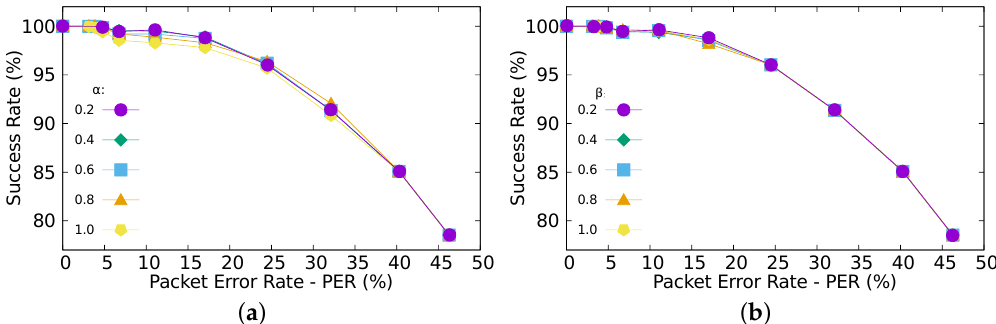
Figure 11. Tuning parameters. ( a ) Effects of varying α parameter; ( b ) Effects of varying β